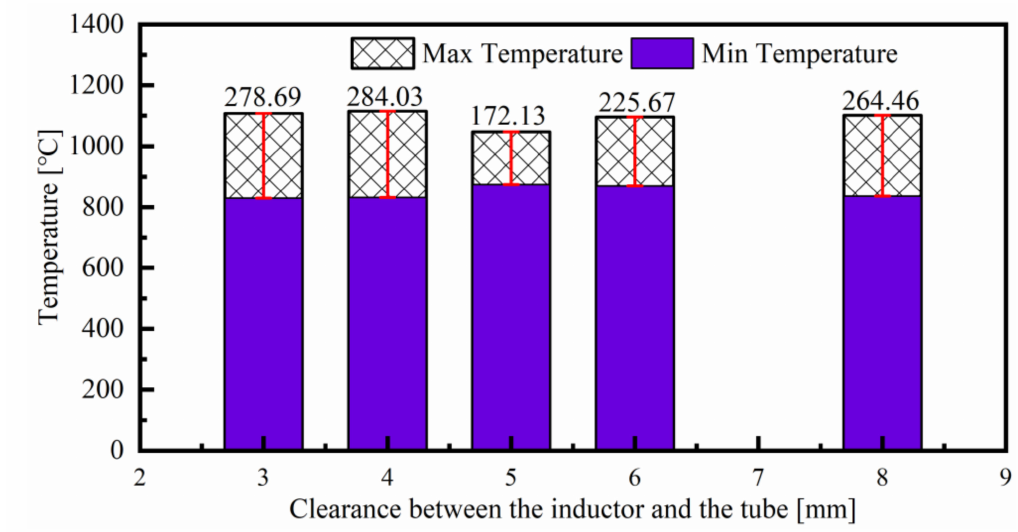
Figure 16. The temperature difference under different clearances between the inductor and the